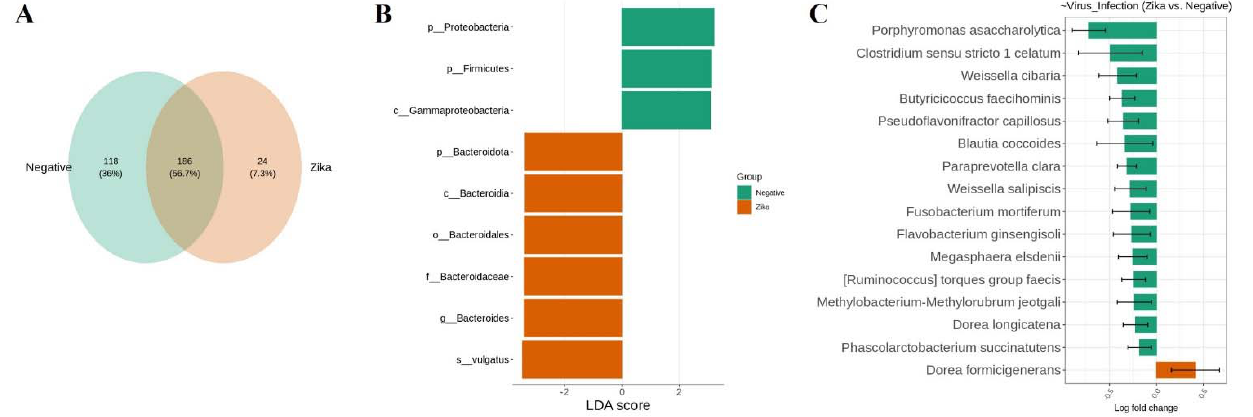
Figure 5. Bacterial community composition of Colombian Ae. Aegypti midguts are naturally infected with ZIKV. ( A ) Venn diagram of bacteria showing the common and unique OTUs between ZIKV-infected and non-infected females. ( B ) An abundance of bacterial taxa among groups using LefSe analysis. LDA scores of biomarker bacteria are shown as horizontal bars for biomarker bacteria with an LDA score (log10) > three and with an alpha value of 0.05. ( C ) Differential abundance analysis stratified by ZIKV infection using ANCOM-BC (significant at